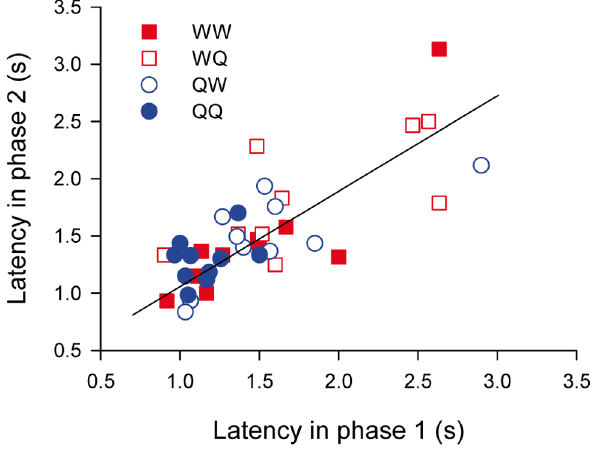
Figure 4. Correlation between choice latencies at the end of phases 1 and 2. Each dot represents the choice latencies (in seconds) during trials 14 and 29 for an individual bee. Symbol type indicates the treatment to which bees were allocated: red squares represent bees with US- 1 =W, blue circles represent US- 1 =Q. Filled symbols correspond to bees which had the same reinforcer in phases 1 and 2 of the experiment, and empty symbols to bees which had different reinforcers.